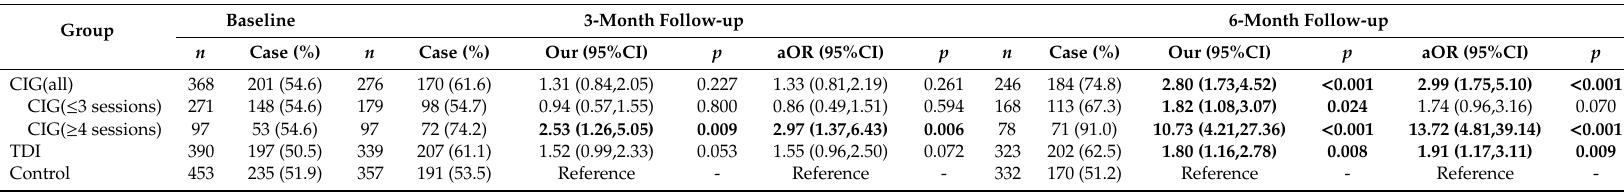
Table 3. Intervention e ff ectiveness on the appropriate use of respiratory protective equipment (RPE) (primary outcome) at 3- and 6-month of intervention ( n = 1211).